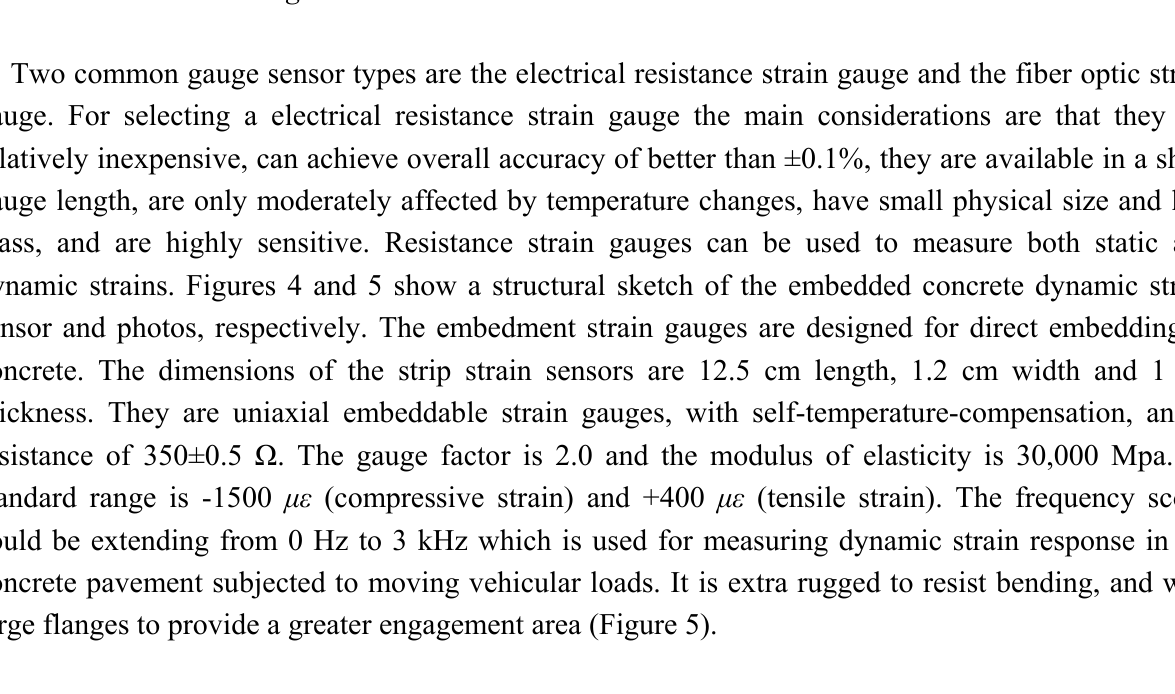
Figure 4. The structural sketch of the embedded strain gauge